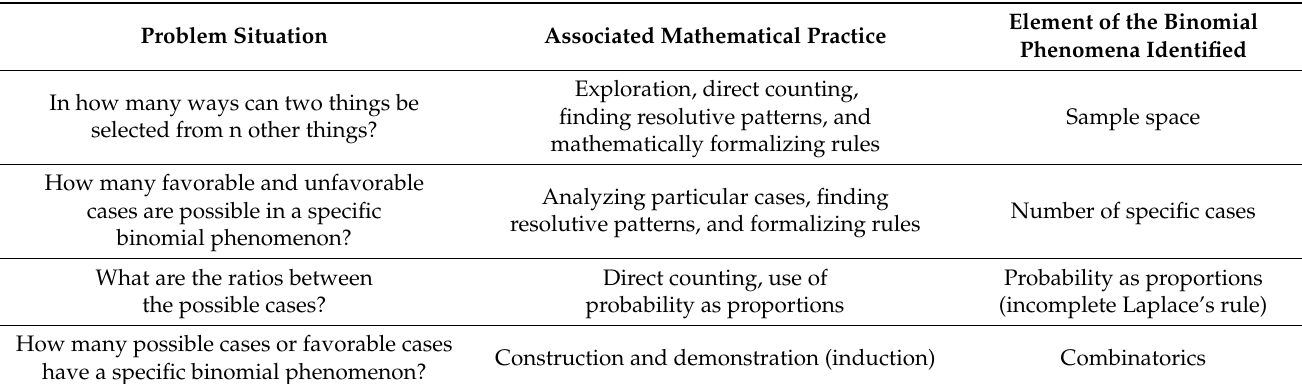
Table 2. How problem situations from historical problem situations (600 BCE—14th century) could be proposed in the current curricula.